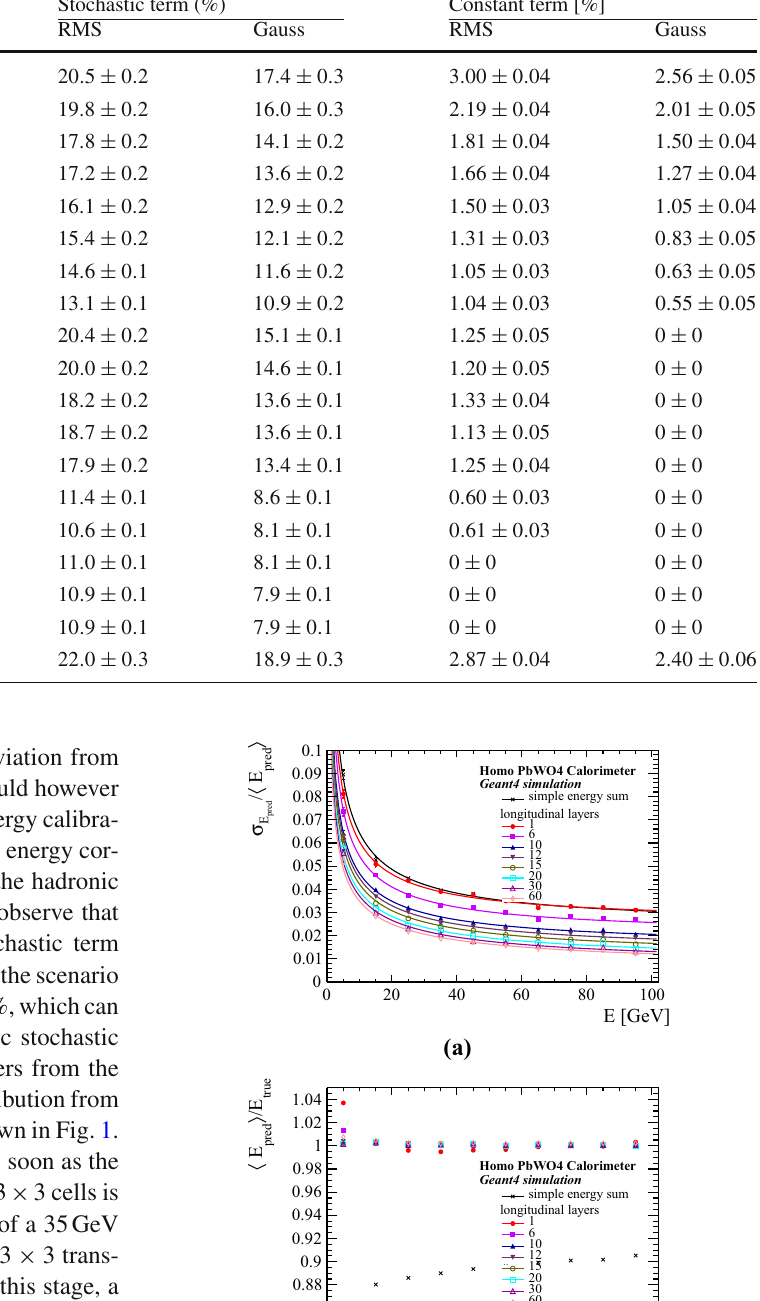
Table 2 Summary of energy